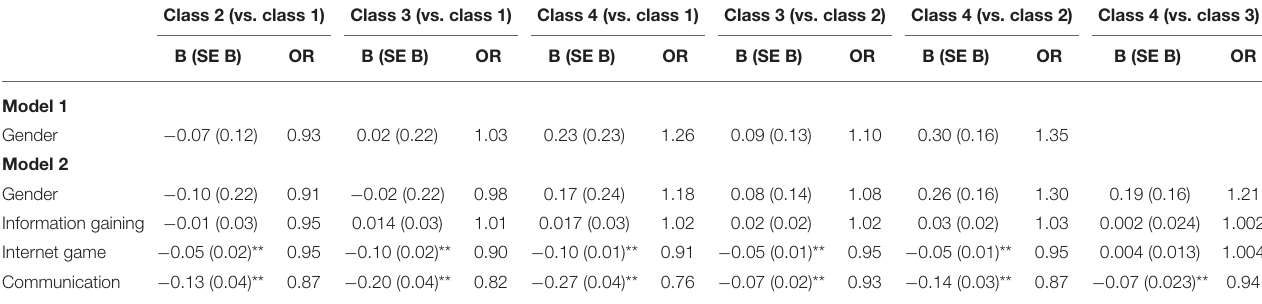
TABLE 3 | Multinomial logistic regressions predicting the Internet use classes from demographic characteristics, information gaining, Internet gaming, and communication variables with classes 1, 2, and 3 as reference groups.